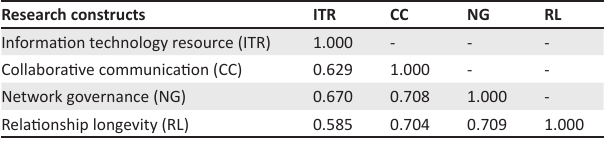
TABLE 3: Correlations between